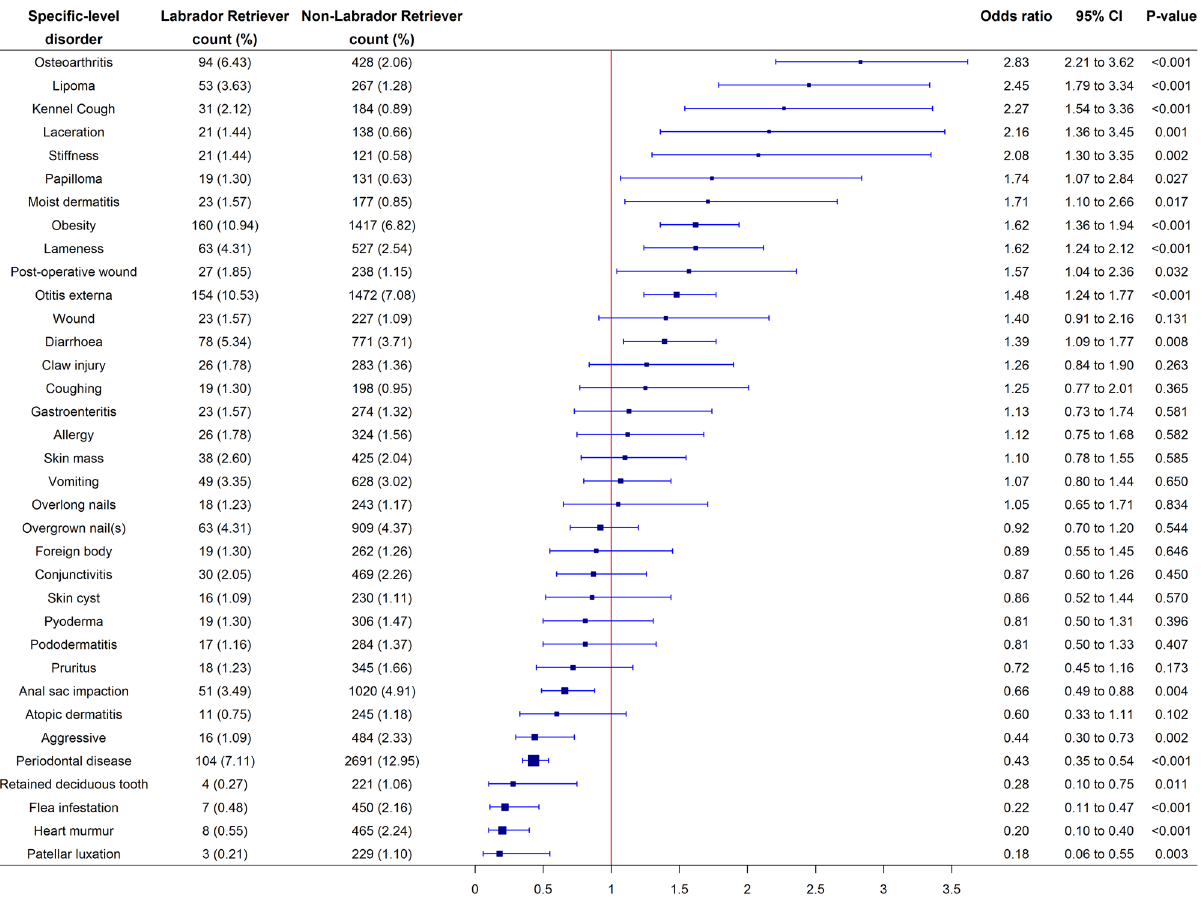
Figure 1. Forest plot of the prevalence and multivariable logistic regression odds ratios with corresponding 95% CIs (confidence intervals) for the combined list from the 30 most common disorders in Labrador Retrievers and the 30 most common disorders in non-Labrador Retrievers at a specific-level of diagnostic precision recorded in dogs under primary veterinary care at UK practices participating in the VetCompass Programme from January 1st 2016 to December 31st, 2016. Model variables accounted for included age, sex-neuter status, at/above or below breed/sex mean bodyweight, insurance status and vet group. Specific-level precision describes the original extracted terms at the maximal diagnostic precision recorded within the clinical